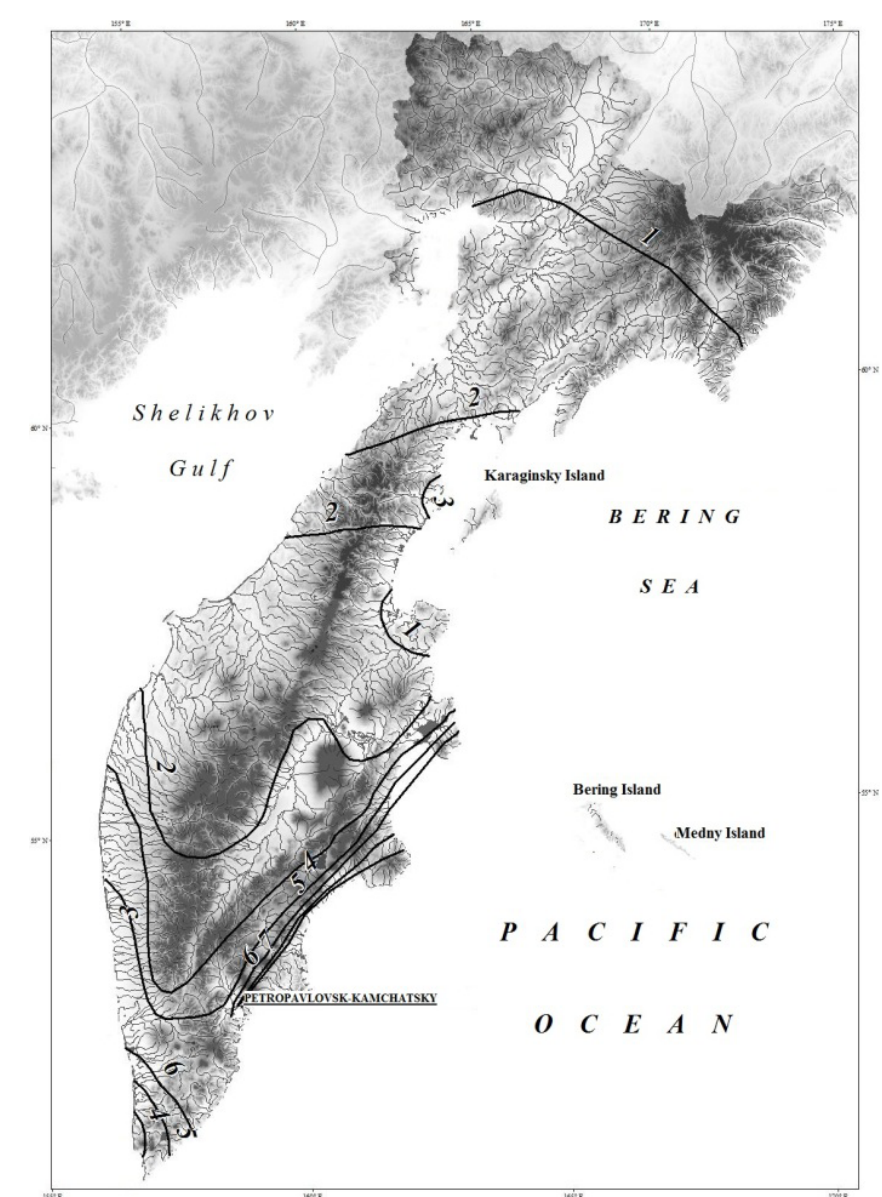
Figure 4. Rainfall erosive factor distribution in the Kamchatsky Krai